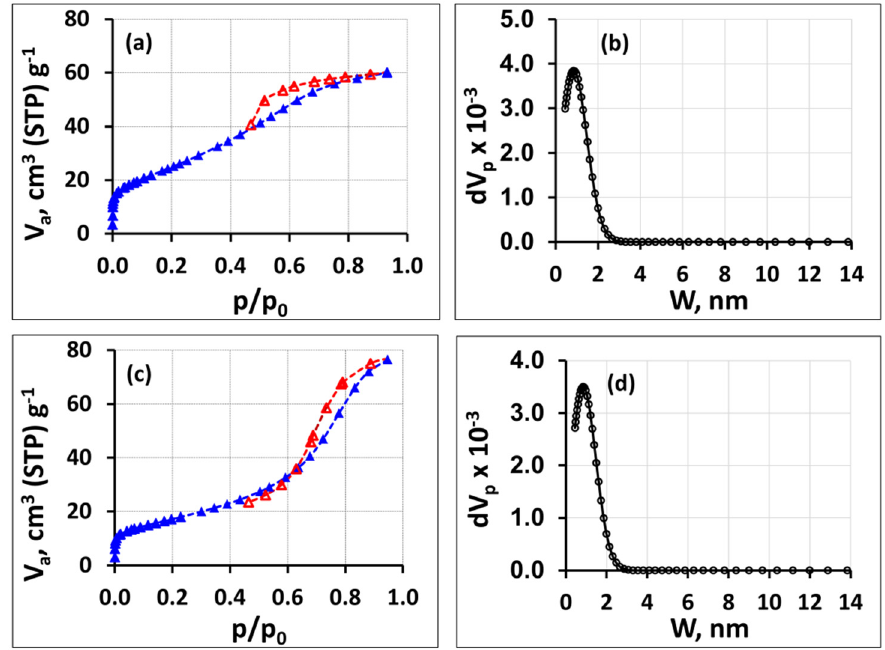
Figure 3. The nitrogen adsorption/desorption isotherms and the corresponding pore size distribution of ( a , b ) ZrO 2 NPs570 and ( c , d ) ZrO 2 NPs700. (Blue lines are adsorption and red lines are desorption in ( a , c ).